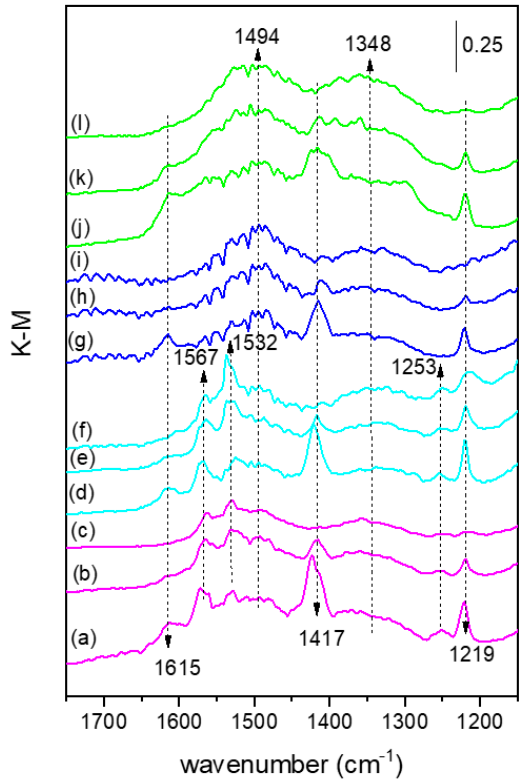
Figure 6. DRIFTS spectra under CO-PROX conditions for the following samples and reaction temperatures. ( a ) 1Zr/CoFe, 25 ◦ C; ( b ) 1Zr/CoFe, 125 ◦ C; ( c ) 1Zr/CoFe, 250 ◦ C; ( d ) 1Co/CoFe, 25 ◦ C; ( e ) 1Co/CoFe, 125 ◦ C; ( f ) 1Co/CoFe, 250 ◦ C; ( g ) 1Cu/CoFe, 25 ◦ C; ( h ) 1Cu/CoFe, 125 ◦ C; ( i ) 1Cu/CoFe, 250 ◦ C; ( j ) 10Ce/CoFe, 25 ◦ C; ( k ) 10Ce/CoFe, 125 ◦ C; ( l ) 10Ce/CoFe, 250 ◦ C.